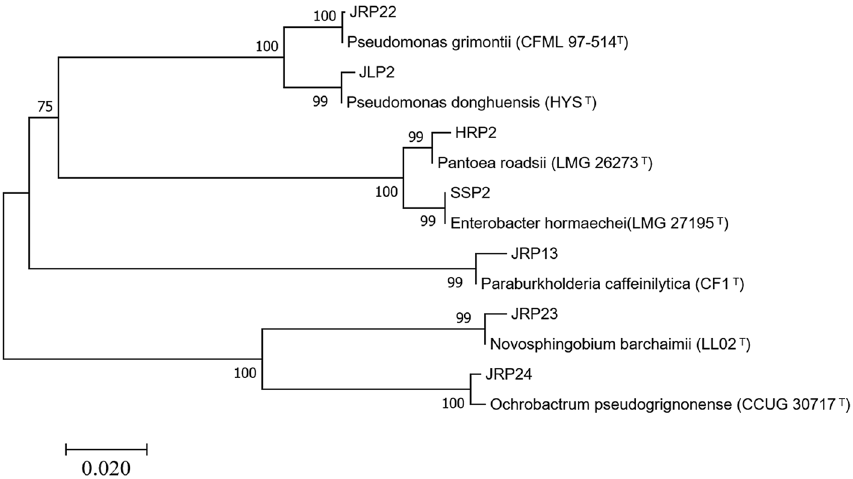
Figure 1. Phylogenetic evolutionary tree based on 16S rRNA sequences.